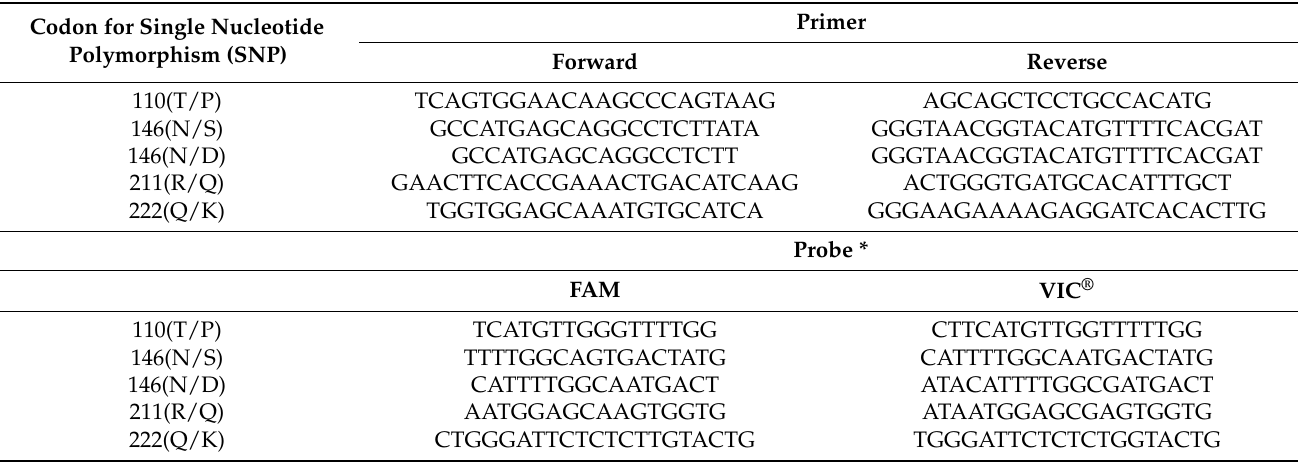
Table 1. Primers and probes sequences used in TaqMan SNP genotyping assays for the detection of polymorphisms 110 (T/P), 146 (N/S), 146 (N/D), 211 (R/Q), and 222 (Q/K). Codon for Single